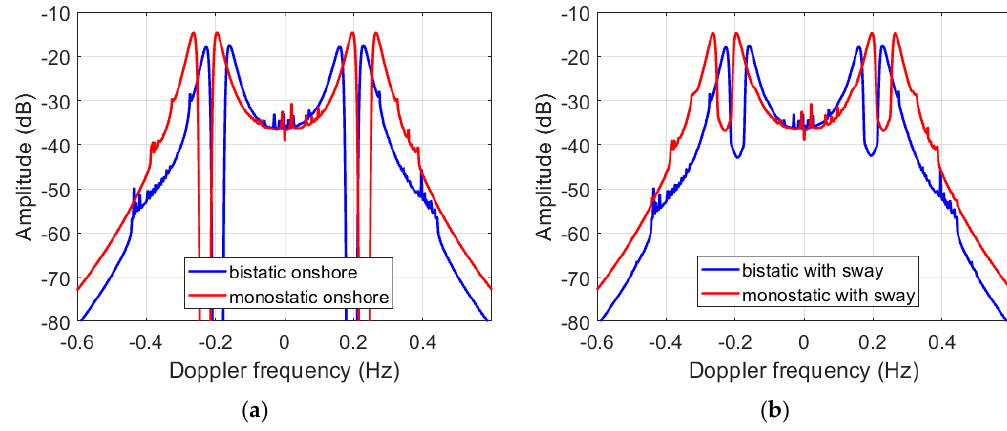
Figure 5. Simulated second-order RCSs, ( a ) for onshore monostatic and bistatic cases; ( b ) for floating-based monostatic and bistatic cases with sway.